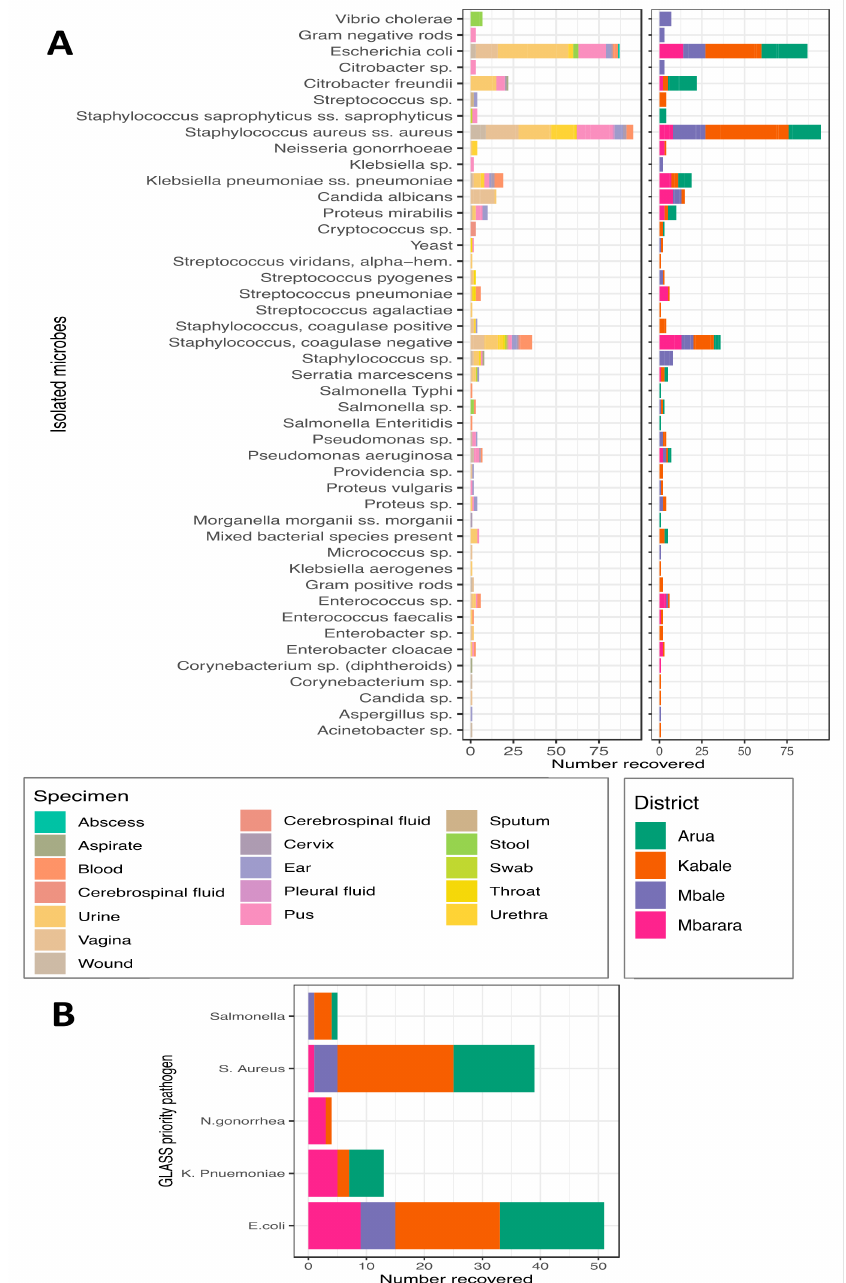
Figure 5. Microbes recovered from the cultured samples in Figure 3 . Here, ( A ) has two panels, the first showing distribution by specimen and the second by district of origin. ( B ) shows the GLASS priority pathogens recovered from each of the district sentinel